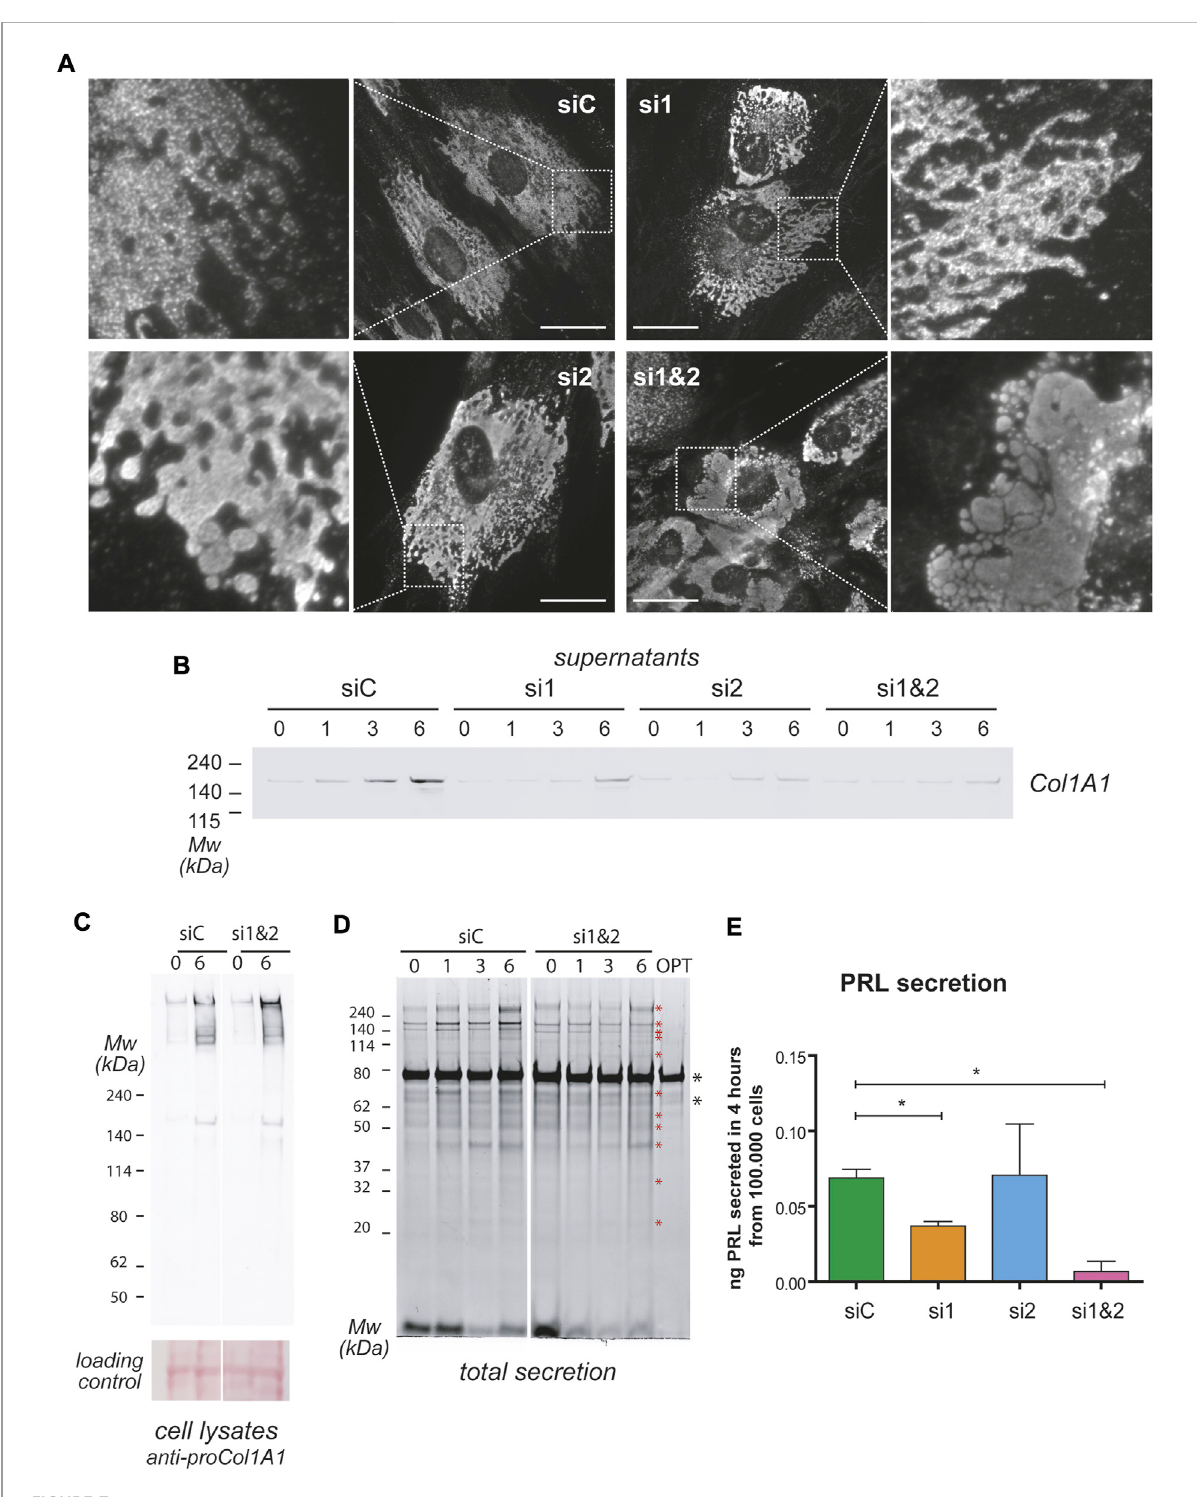
FIGURE 7 CREB3L1 and 2 KD affects general protein secretion. T-HESC were treated with scramble duplexes (siC), with duplexes speci fi c for CREB3L1 (si1), CREB3L2 (si2) or both (si1&2). The day after treatment (day0) cells were treated with cAMP and progesterone and analyzed at different days of the decidualization process as indicated. (A) Images of cells at day 6 of differentiation. Cells were fi xed with PFA, permeabilized and stained with anti Pro-Collagen1A1 antibody. In control cells, procollagen is present in the ER. The KD of CREB3L1 and/or 2 dramatically increases the amount of intracellularPro-Collagen1A1,withswellingoftheER,culminatinginRussellBodies-likestructuresinconditionsofdoubleKD.Imageswereacquired